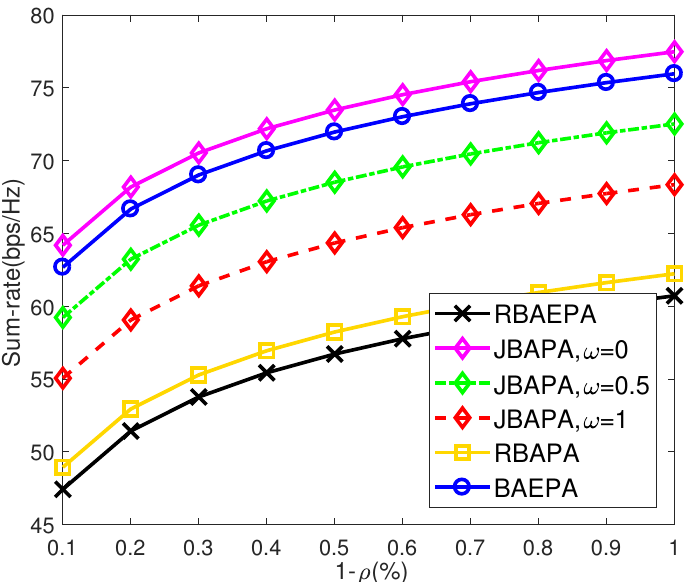
Figure 4. Comparison of the sum-rate of different schemes, where η =